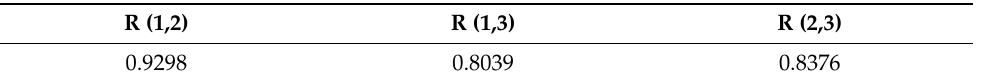
Table 2. The coefficients of correlation between reaction time deviations of the students for the questions 1–3. Arguments 1–3 stand for the number of the question.